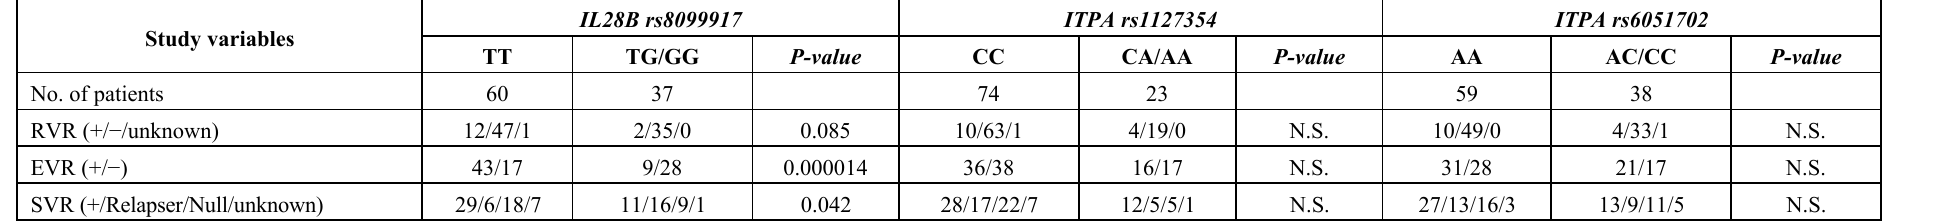
Table 3. Treatment response in patients grouped according to IL28B and ITPA genetic